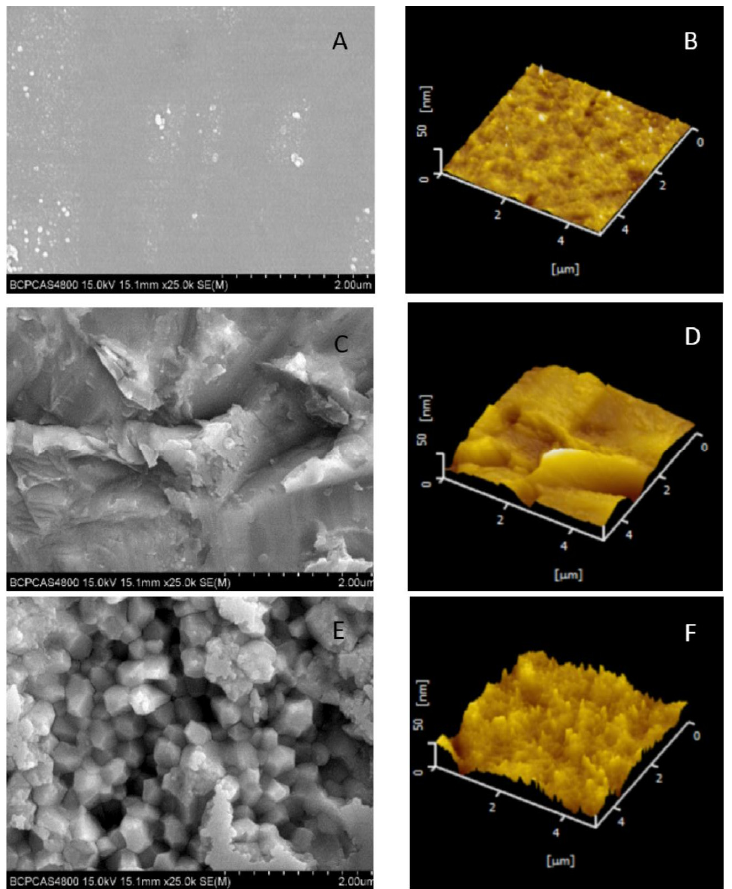
Figure 1. Scanning electron microscopy photomicrographs and atomic force microscopy images of zirconia ceramic discs after different surface treatments. ( A , B ) blank control; ( C , D ) airborne ‐ particle ‐ abrasion; and ( E , F ) hot ‐ etching treatment.